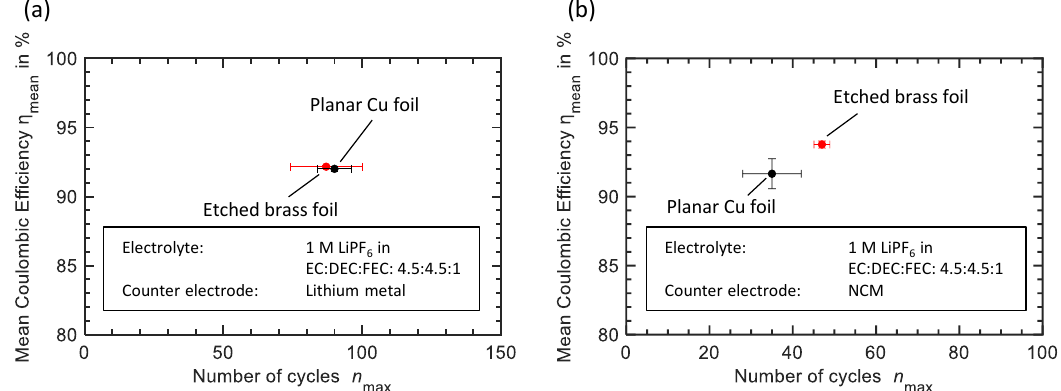
Figure 4. Cycle performance of different current collectors for Li electrodes with an electrolyte of 1M LiPF 6 in EC:DEC:FEC: 4.5:4.5:1 (wt.) represented as the mean Coulombic efficiency η mean and the mean maximum number of cycles n max with standard deviation with Q lithiation = 1mAh/cm 2 and J = 1mA/cm 2 . ( a ) Experiments against Li counter electrode ( b ) Experiments against NCM counter